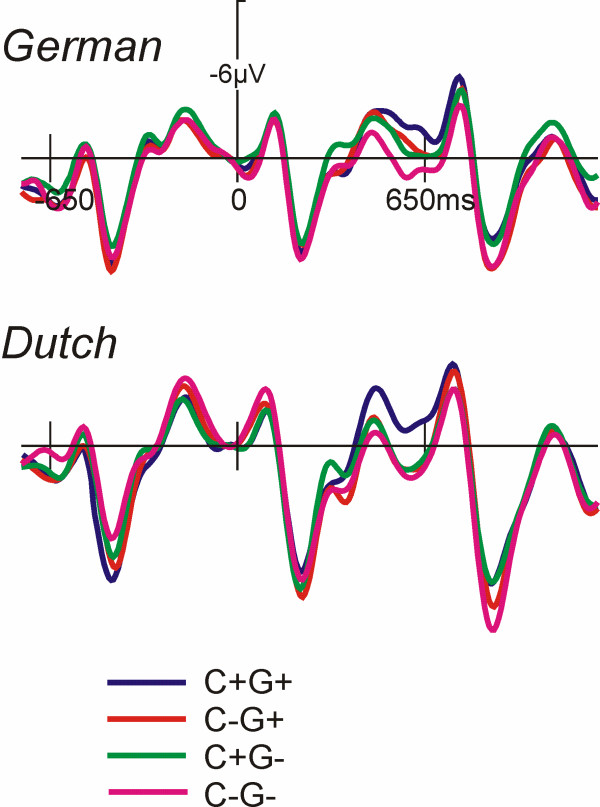
Group average potentials from both studies (Cz-site) plotted with a longer time-base. The 100 ms prior to the appearance of the pronoun (time = 0) were used for a baseline. The tick-marks mark the onset of the words. There are no systematic effects prior to the pronoun in both experiments. Also, no effects are observed for the word following the pronoun.